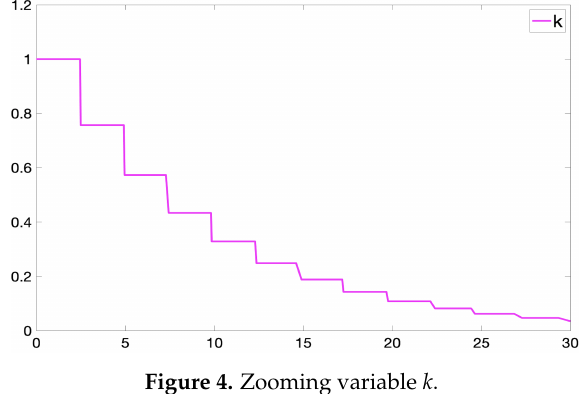
Figure 4. Zooming variable k